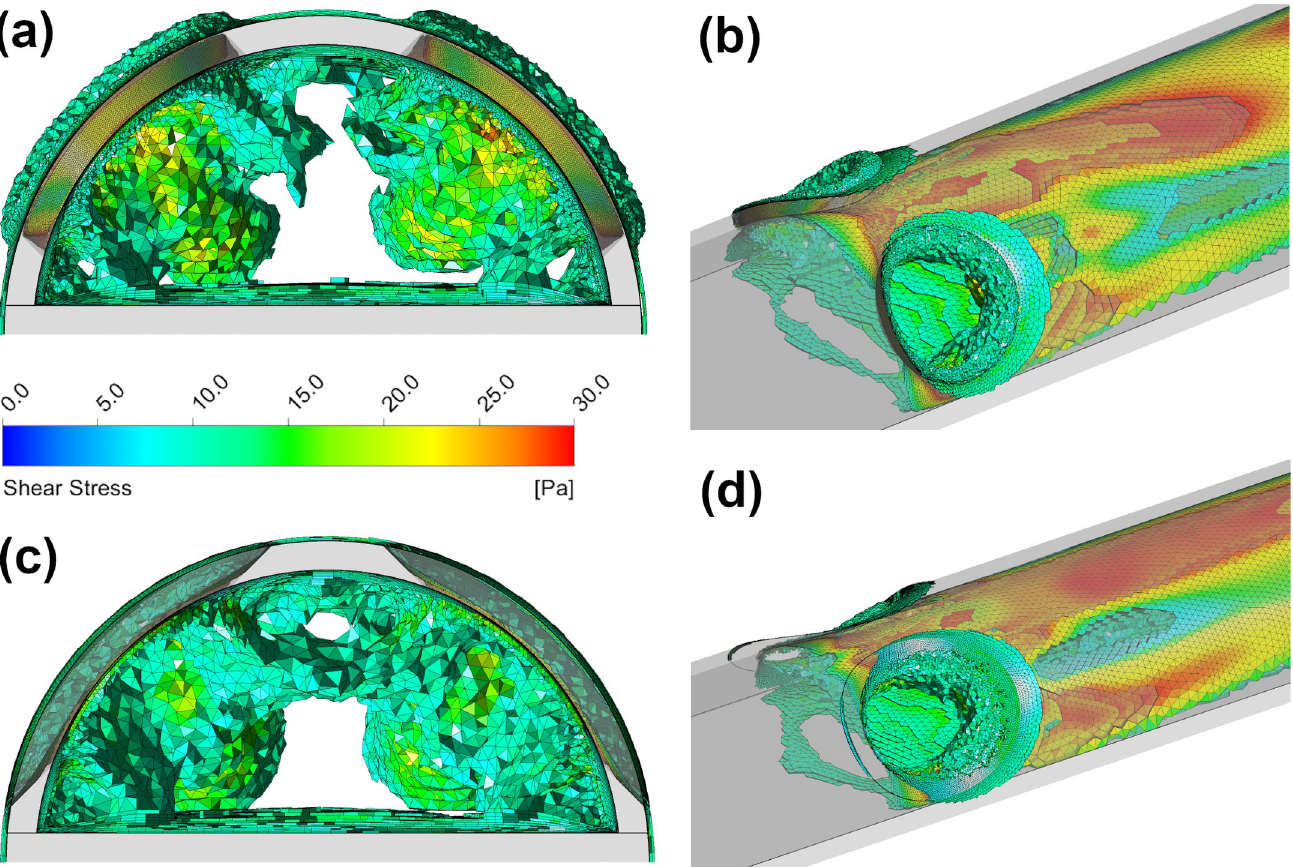
Fig 9. Regions inside the tip volume where shear stress > 10 Pa for the dual-hole parallel circular (a)-(b) and oval (c)-(d) configurations.